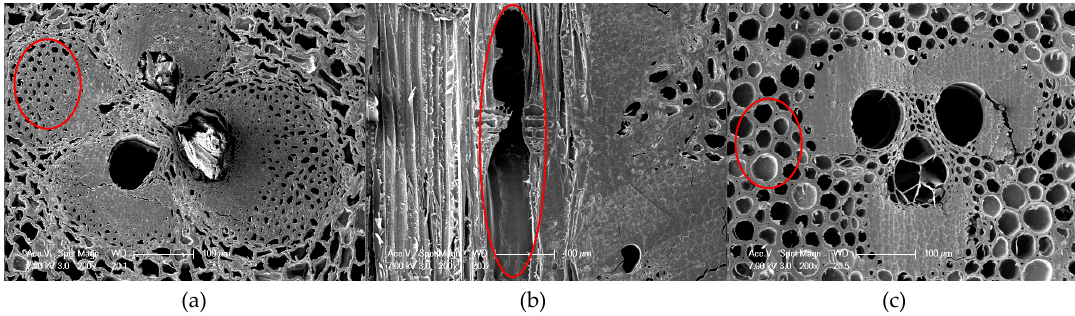
Figure 2. The typical structure of the electron micrographs of three types of bamboo composites at 200× magnification. ( a ) BS; ( b ) BLVL; ( c ) BLT.